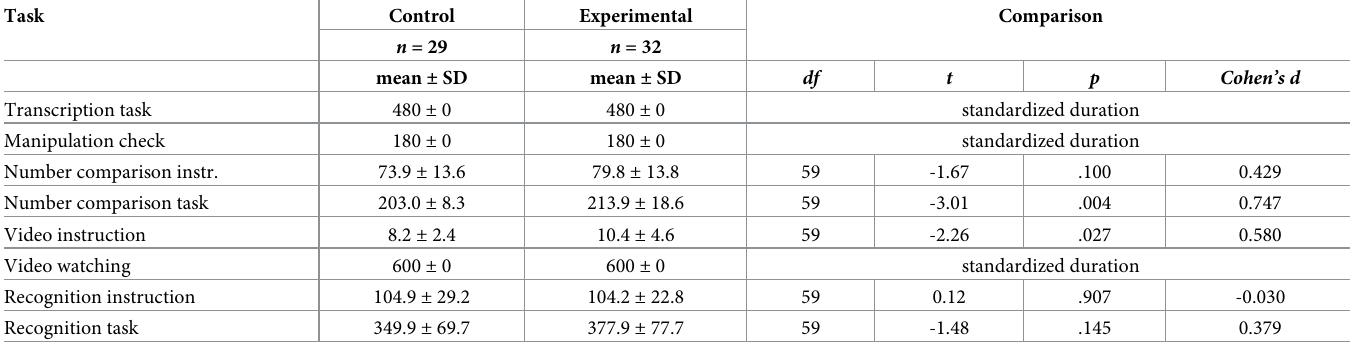
Table 4. Time on